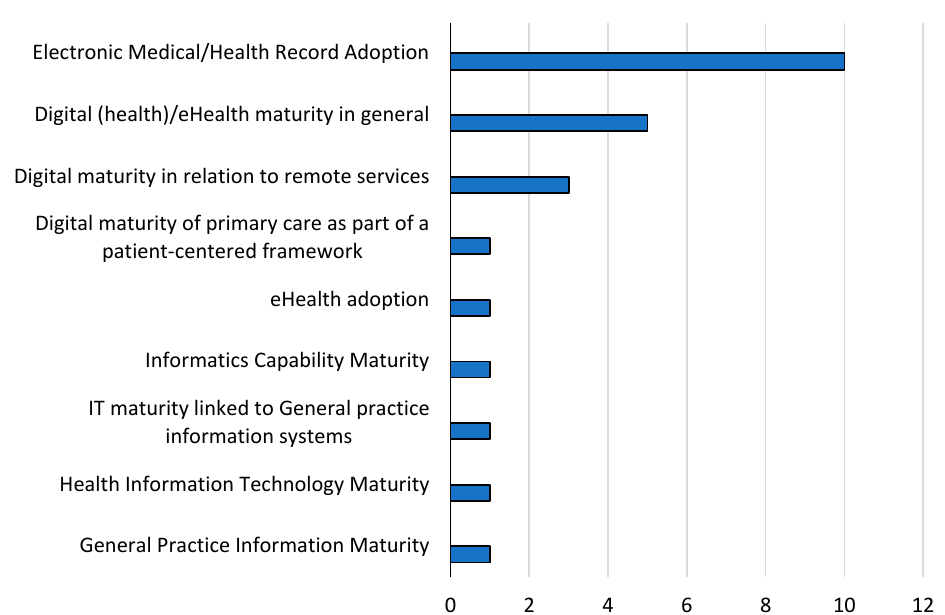
Figure 3. Geographical distribution of digital maturity examined in the included studies.